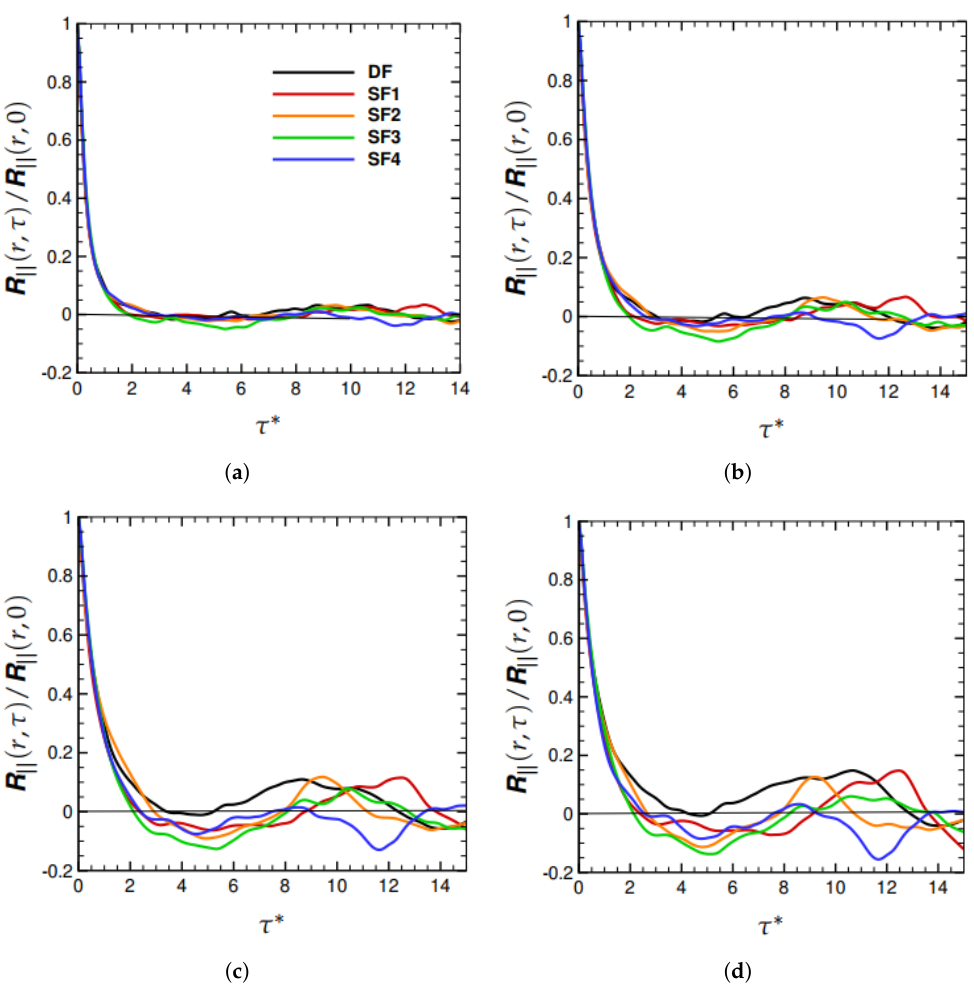
Figure 1. R || ( r , τ ) = (cid:104) ∆ u ( r , x ,0 ) ∆ u ( r , x , τ ) (cid:105) || as a function of dimensionless time separation, τ ∗ = τ u rms / L , for Re λ = 80. ( a ) r / L = 0.56, ( b ) r / L = 1.12, ( c ) r / L = 2.24, and ( d ) r / L =